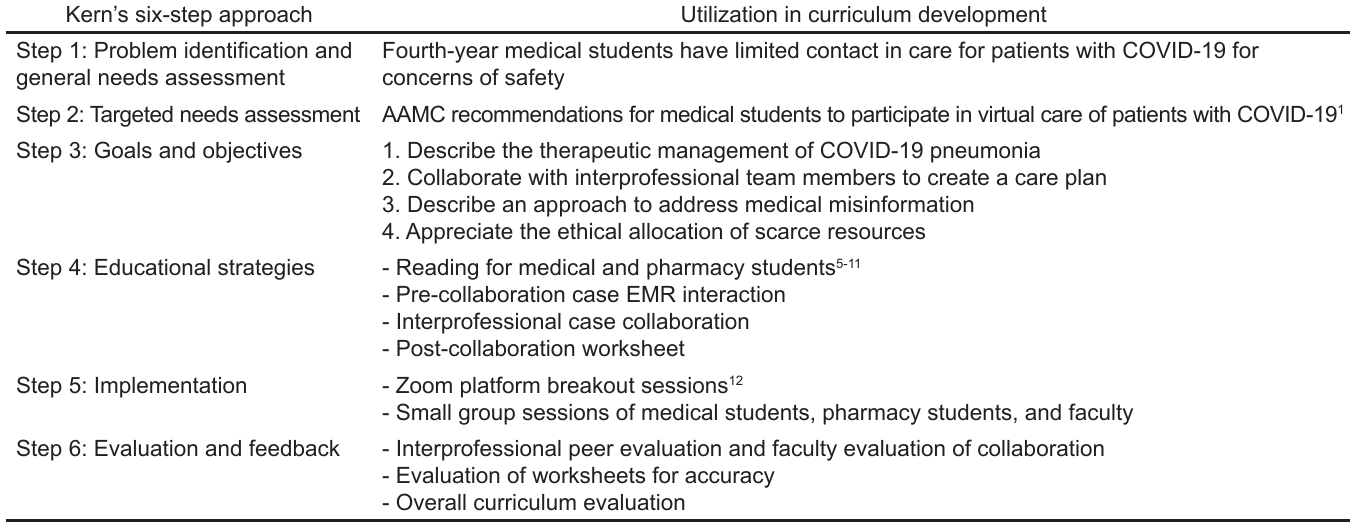
Table 1. Utilization of Kern’s six-step approach for curricular development. Kern’s six-step